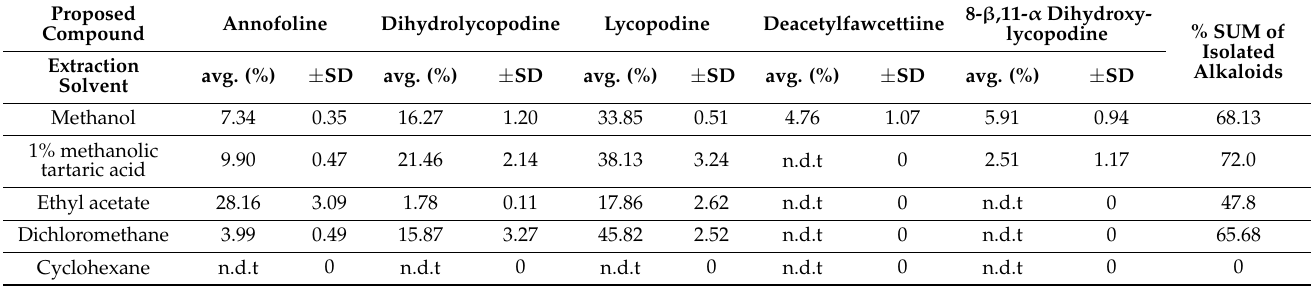
Table 1. Pressurized liquid extraction (PLE) of Lycopodium clavatum L. using five kind of solvent systems (Section 3.2) and purified by solid-phase extraction (SPE) procedure (Section 3.3) and the five main alkaloids were isolated with different